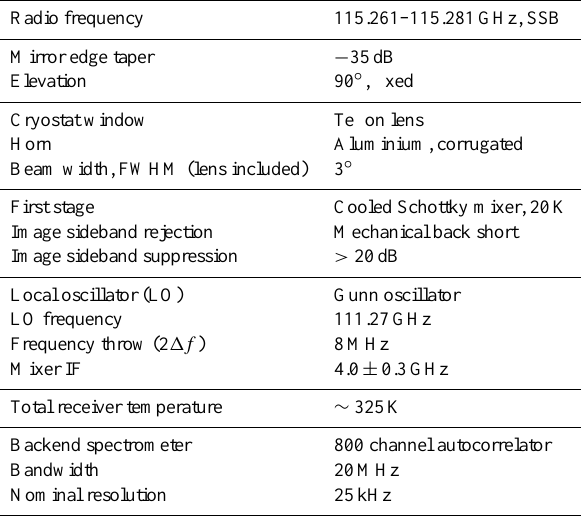
Fig. 2. To the left: measured spectra (4h average) with retrieval fits. To the right: residuals (measured spectrum–fit). The frequencies are given relative to the CO line center. The negative and positive peaks are the result of the frequency throw in the frequency-switching method. The spectra are corrected for baseline features. Note the weak CO signal in the summer (bottom